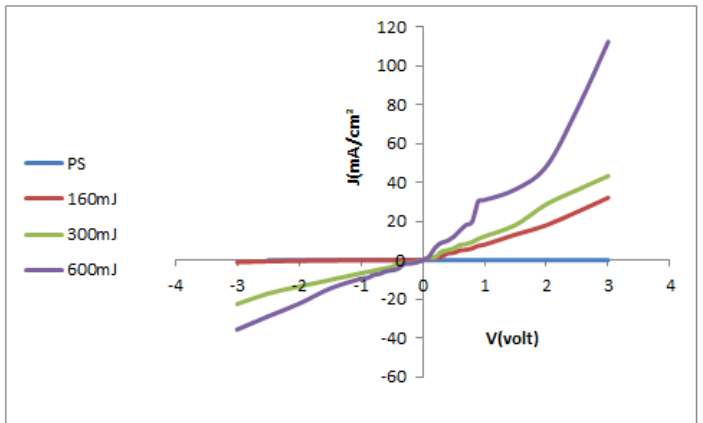
Fig. 12: The I-V characteristics of Al/AuNPs /PS/c-Si /Al when AuNPs prepare at different laser ablation.